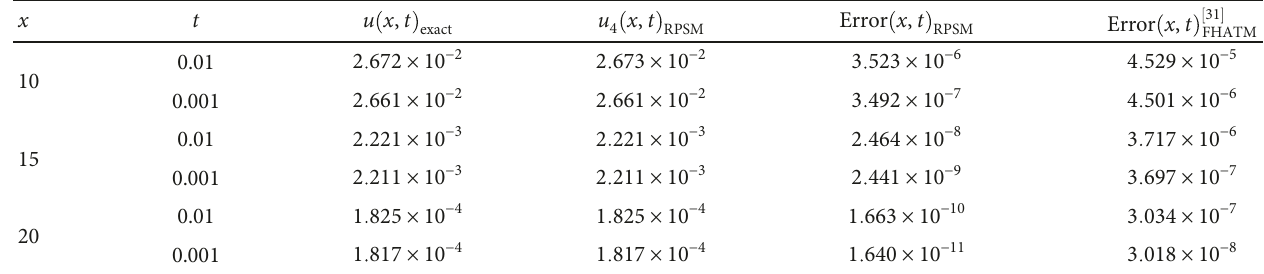
Table 2: Comparison between Error x , t